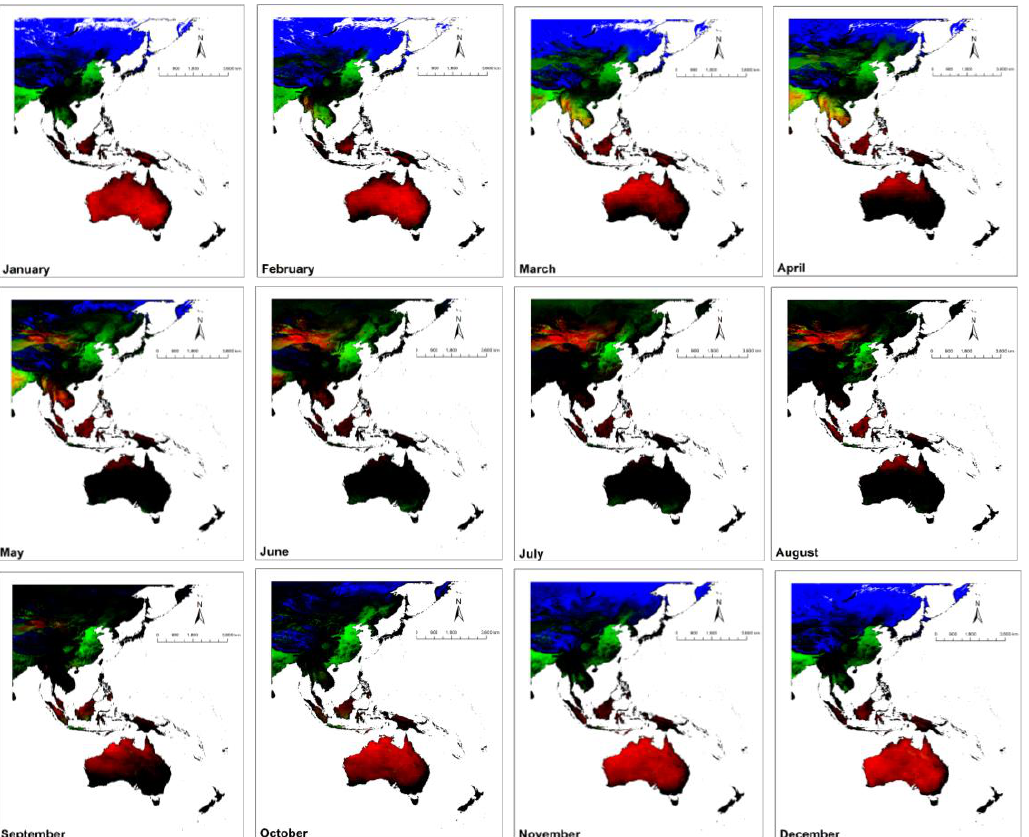
Figure 7. Mean monthly effects of temperature (Red), dust (Green) and snow (Blue) in RGB display (color wheel is shown in Fig. 8).